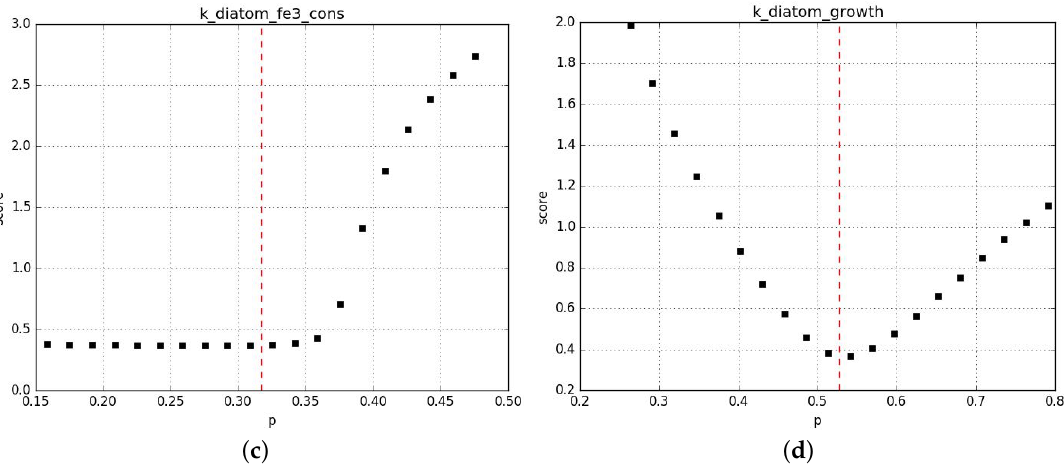
( c ) ( d ) ( D ) Figure A6. Profiling of the parameters v cons in CM ( a ) and MM ( c ) and γ D in CM ( b ) and MM ( d ). Fe The red line shows the value chosen by the